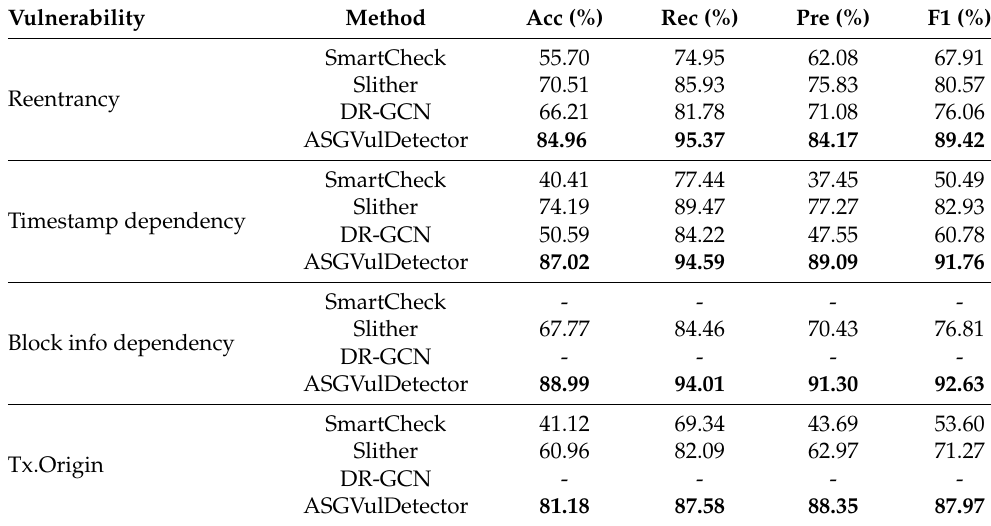
Table 3. Performance comparison for ASGVulDetector (‘-’ denotes not applicable). Vulnerability